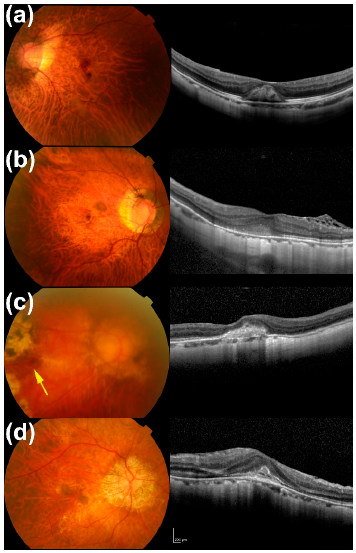
Figure 2. Representative initial fundus photographs and optical coherence tomography (OCT) images of the patients with or without low ( a , b ) and high ( c , d ) hyperreflective material (HRM) intensity. ( a ) A 50-year-old man whose eye had a low HRM intensity (45.3); the respective best-corrected visual acuities (BCVAs) at baseline, 1 month, and 12 months were 0.30, 0.15, and 0.05 in LogMAR. ( b ) A 64-year-old man whose eye had a low HRM intensity (60.7); the respective BCVAs at baseline, 1 month, and 12 months were 0.097, 0.05, and − 0.079 in LogMAR. ( c ) A 68-year-old woman whose eye had high HRM intensity (105.4); the respective BCVAs at baseline, 1 month, and 12 months were 1.30, 1.00, and 1.22 in LogMAR. Arrow in the fundus photograph shows the lesion. ( d ) A 73-year-old man whose eye had a high HRM intensity (91.0); the respective BCVAs at baseline, 1 month, and 12 months were 0.222, 0.301, and 0.155 in